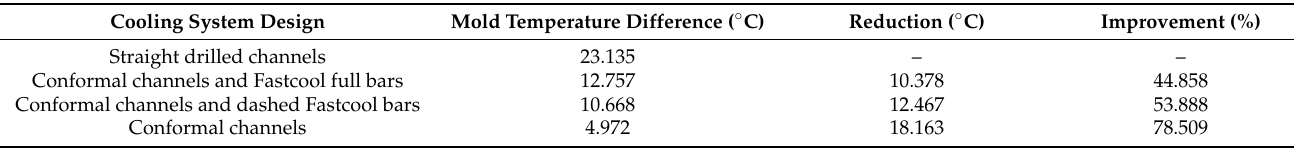
Table 11. Mold temperature difference parameter for each cooling system